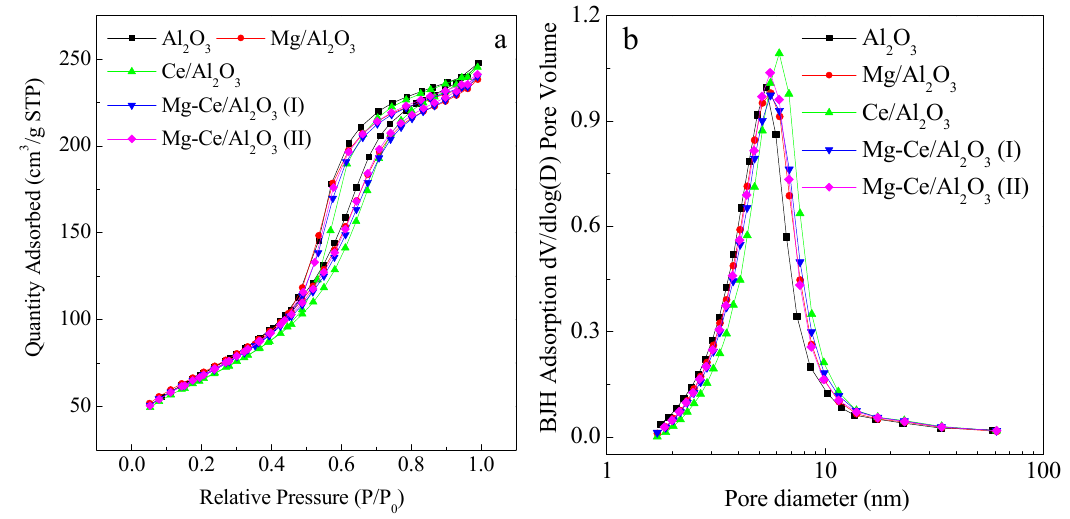
Figure 3. Isotherms ( a ) and pore distribution curves ( b ) using N 2 adsorption ‐ desorption of Al 2 O 3 and metal oxide ‐ loaded Al 2 O 3 catalysts. Table 1. Surface areas, pore structures, and metal oxide contents of Al 2 O 3 and metal oxide ‐ loaded Al 2 O 3 catalysts. Catalysts